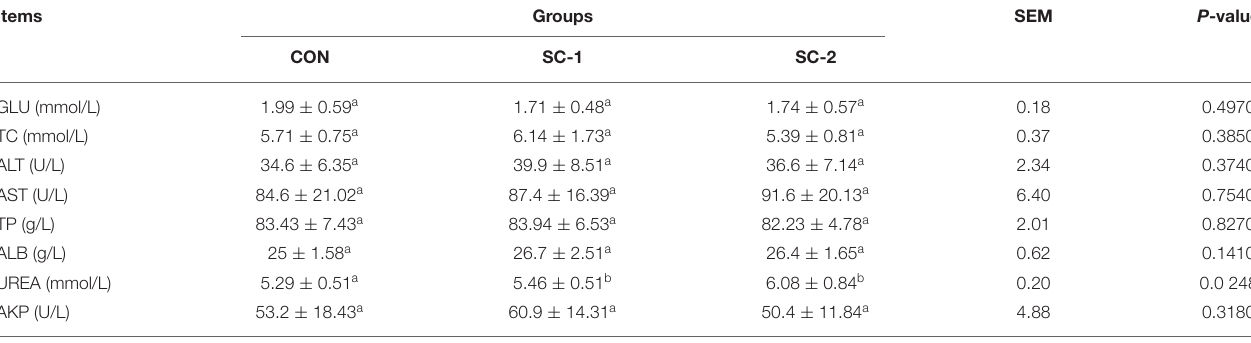
TABLE 5 | Effect of different Saccharomyces cerevisiae cultures on serum biochemical indices of dairy cows. Items Groups